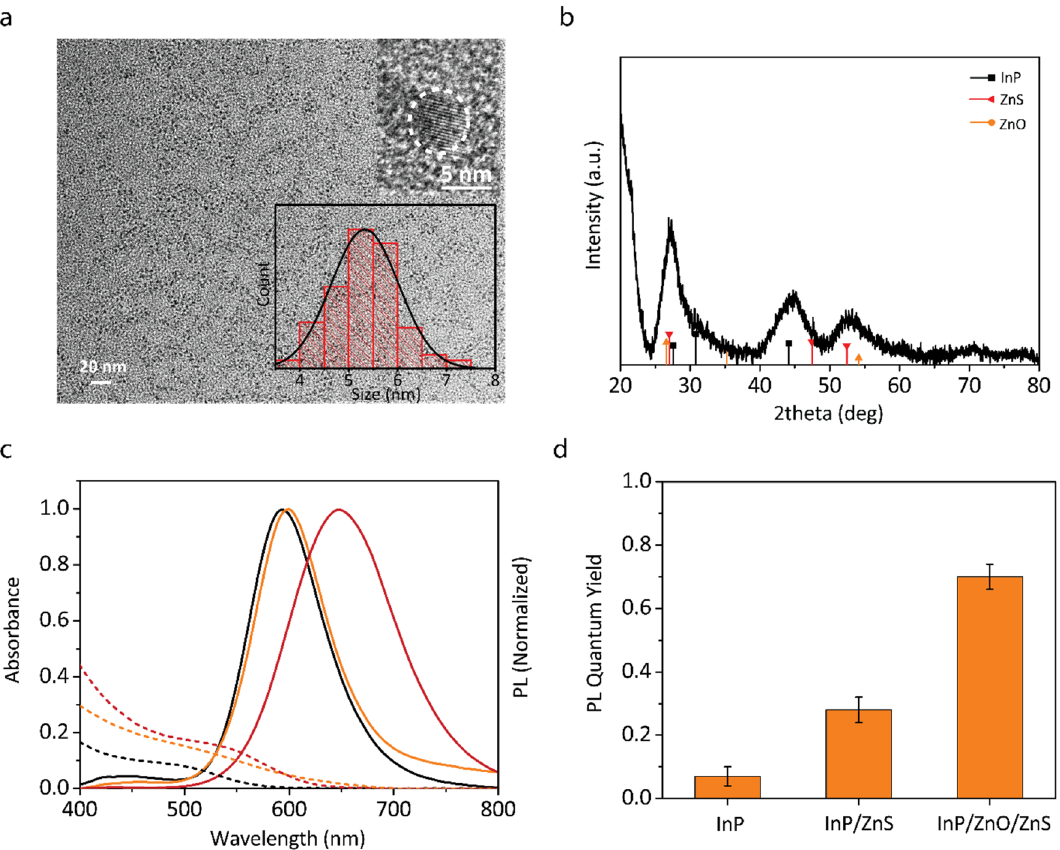
Figure 2. Structural and optical properties of QDs. ( a ) TEM image of InP/ZnO/ZnS QD. Scale bar is 20 nm. Insets: HR-TEM image of InP/ZnO/ZnS QD with 5 nm scale bar (top), the size distribution (N = 200) (bottom). ( b ) XRD pattern of InP/ZnO/ZnS QD. ( c ) Absorption and emission spectrum of InP core (black), InP/ZnS (orange) and InP/ZnO/ZnS (red) QDs dispersed in toluene each at the concentration of ~ 0.5 micromolar. ( d ) PL quantum yields of InP, InP/ZnS and InP/ZnO/ZnS QDs (measured in an integrating sphere with excitation wavelength of 375